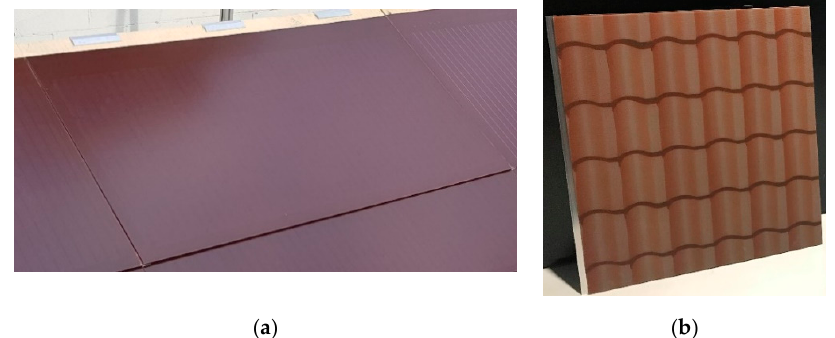
Figure 4. Tested modules samples: Suncol ® Tile-Terracotta Simil RAL 8015 ( a ); and Suncol ® Tile-Texturing Simil roof tile ( b ). Table 2. Detail of the two tested modules typologies.